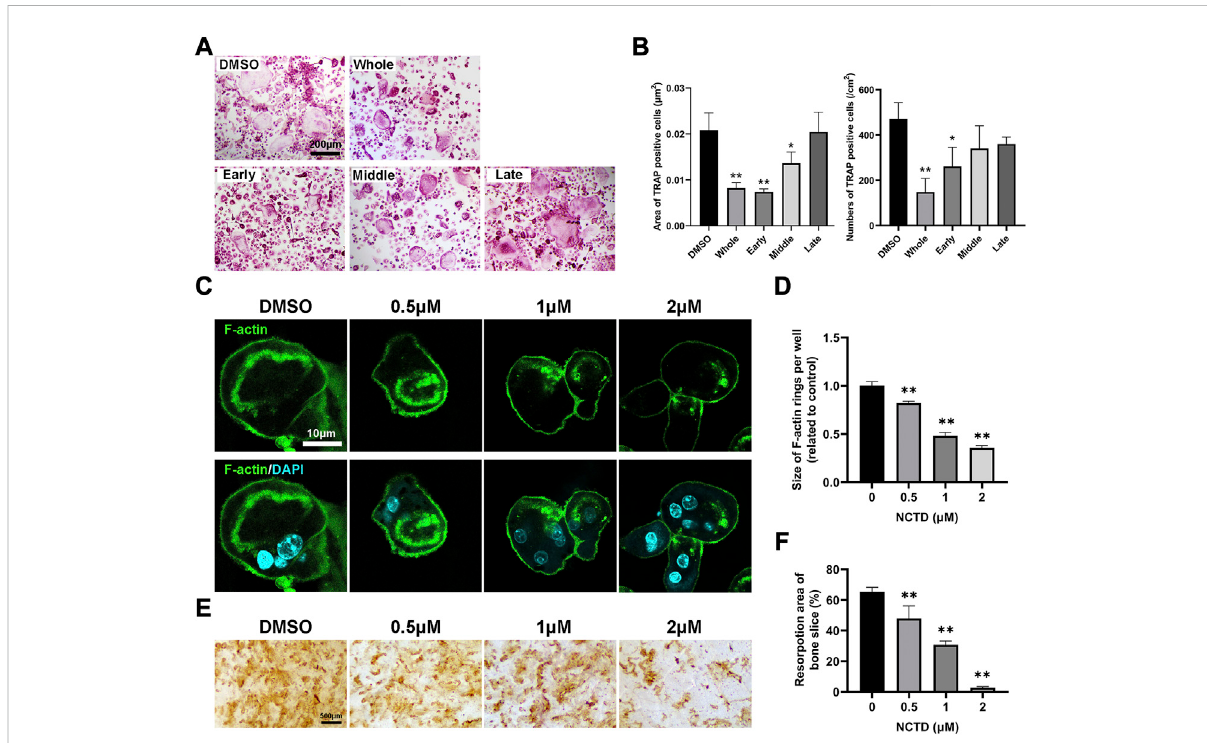
FIGURE 2 NCTD inhibited the formation of F-actin rings in osteoclasts and inhibited bone resorption. (A) The effects of NCTD treatment at different time periods (Early stage, middle stage and late stage) on osteoclast formation were observed with the light microscope. (B) The areas and numbers of osteoclasts in BMM cells treated by NCTD at different stages were quanti fi ed. (C) BMM was induced into osteoclasts on bone slices. After treatment withdifferentconcentrationsofdrugs,FITC-PhalloidinandDAPIstainingwereperformedandobservedby fl uorescencemicroscope. (D) While observing the F-actin ring in theprocess of BMM inducing osteoclast, thesize of F-actin ring was quanti fi ed. (E,F) BMM was induced into osteoclasts on bone slices, and the effect of different concentrations of NCTD on bone resorption was observed. Furtherly, the results of bone resorption were further quanti fi ed. All experiments were repeated independently for three times. Values are expressed as mean ± SD; * p < 0.05, ** p < 0.01 vs. the control